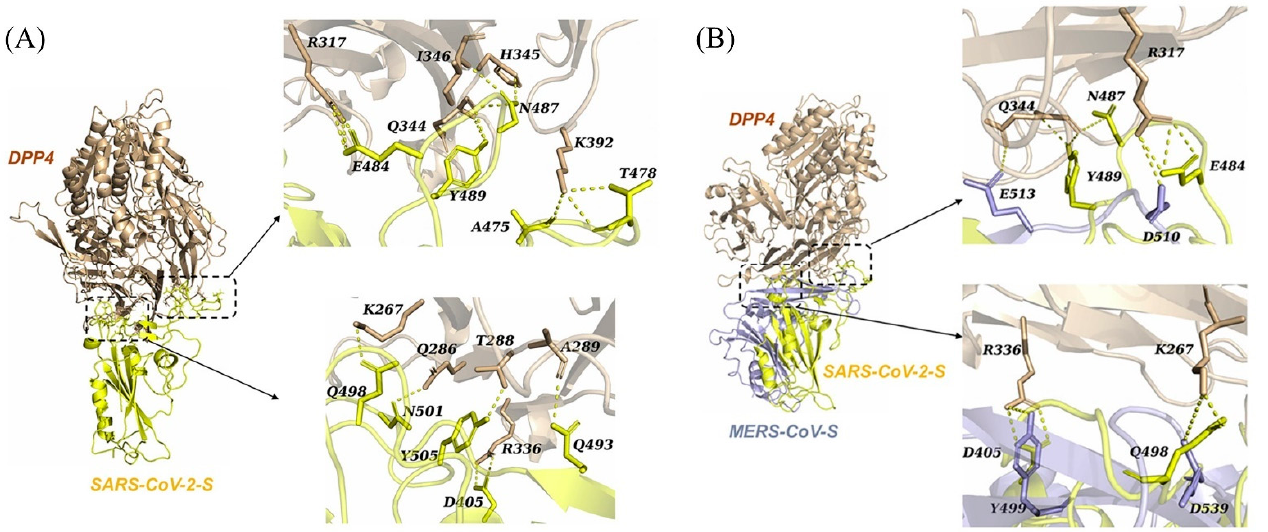
Figure 2. Predicted interactions of the RBD of SARS-CoV-2 with DPP4. ( A ) Key residues predicted in the binding interactions between SARS-CoV-2 (yellow) and DPP4 (wheat). ( B ) Comparison of the residues in ( A ) to the residues in MERS-CoV (purple) known to bind to DPP4. Image taken from Li et al. [5]. Licensed under the Creative Commons Attribution-Non-Commercial-No Derivative Works 4.0 International License.